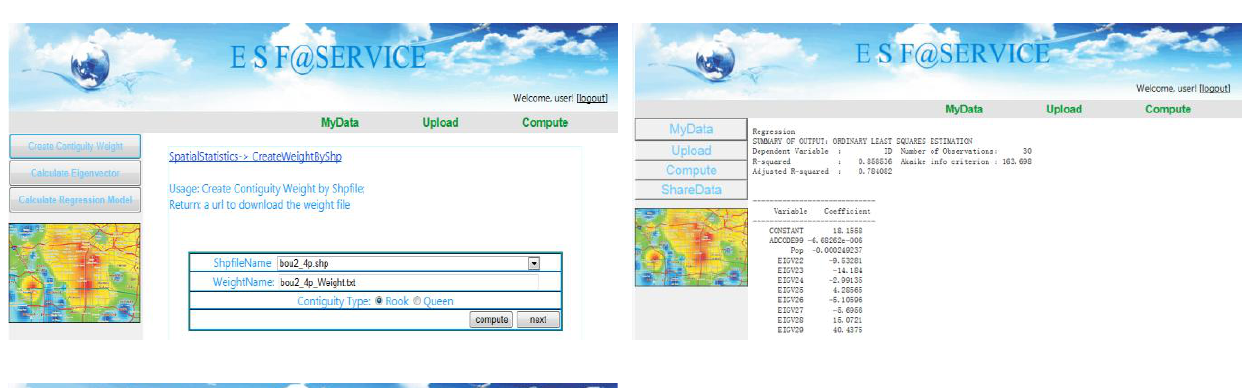
Figure 10. The result of regression analysis